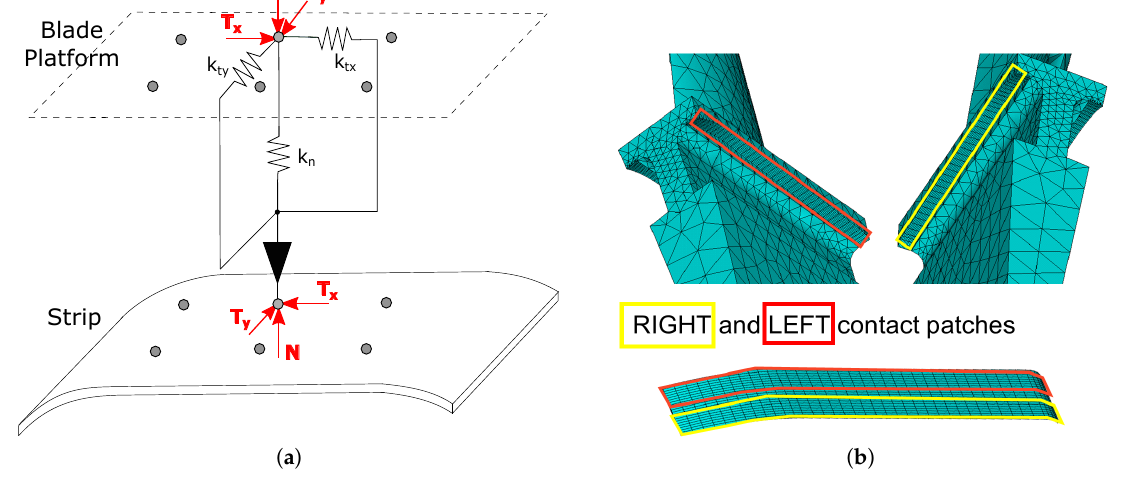
Figure 2. ( a ) Contact model with three contact springs. ( b ) Contact patches on the blade platforms and on the strip